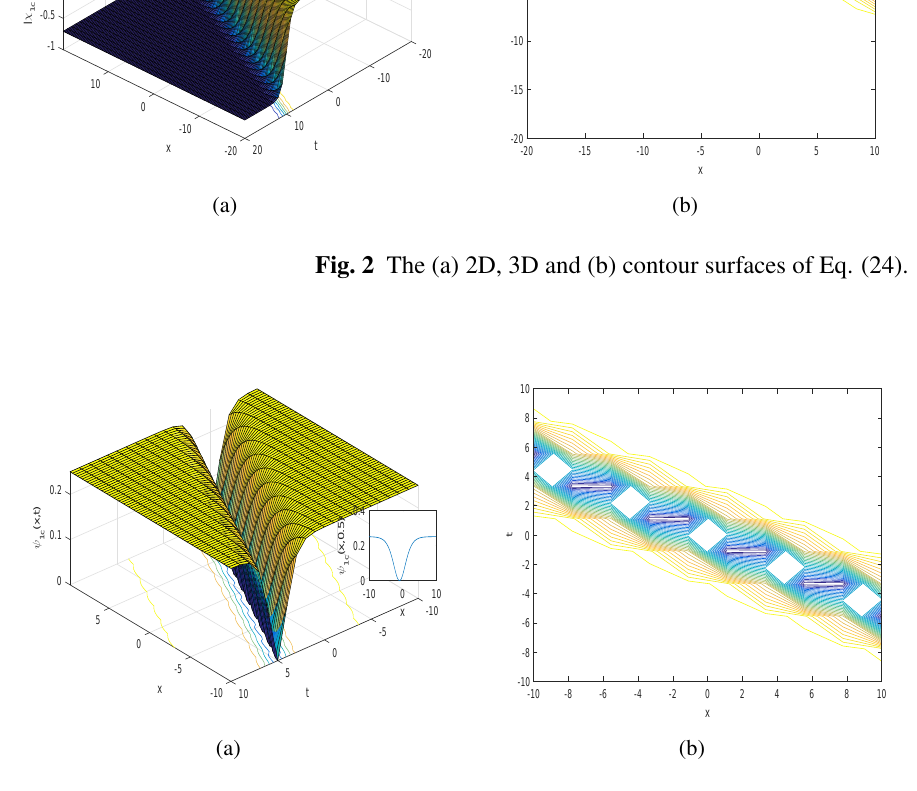
Fig. 3 The (a) 2D, 3D and (b) contour surfaces of Eq.